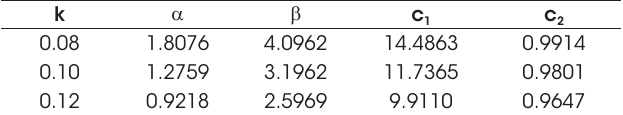
Parameters of the OTTOSEN